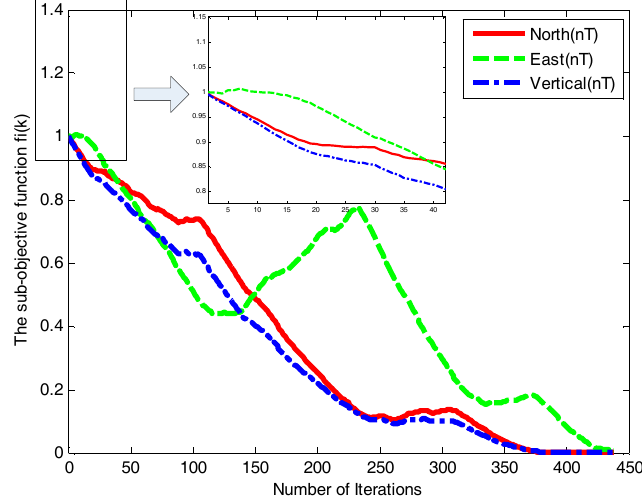
Figure 11. Three components convergencecurvesof the GDSA.